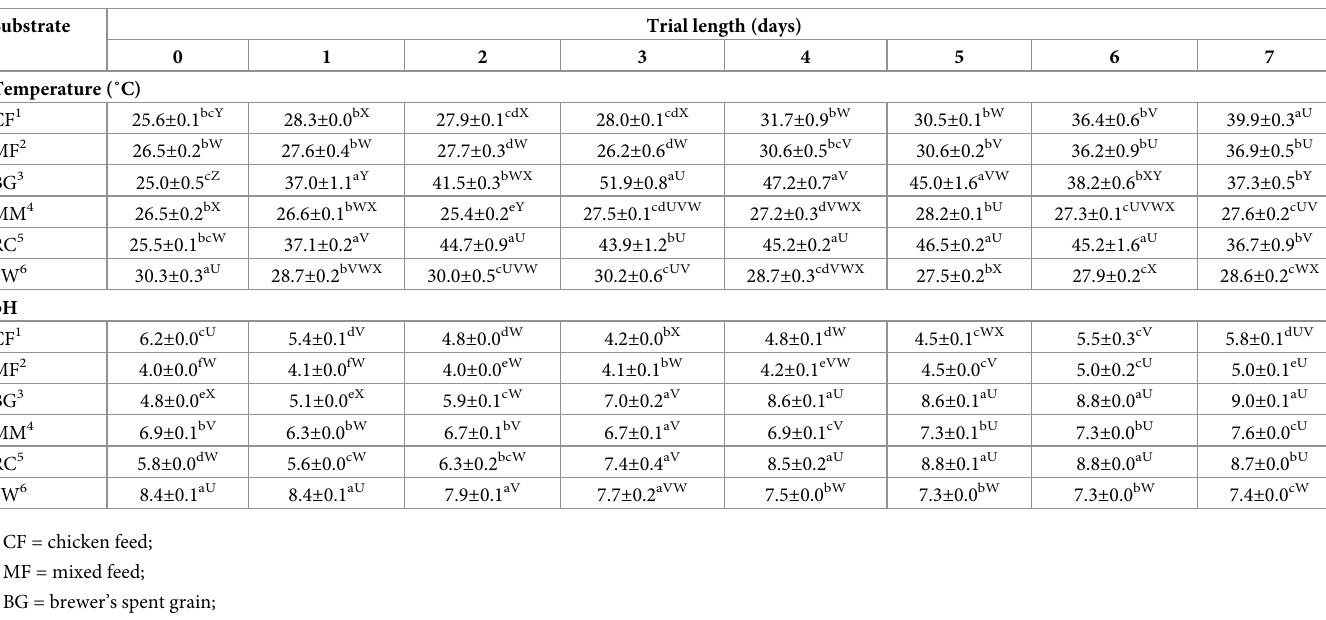
Table 3. Mean ± standard error (n = 3) temperature (˚C) and pH of rearing substrates during the trial. Dissimilar lower case superscript letters represent significant differences between means within the same column and dissimilar capital letters represent significant differences between means within the same row of either temperature or